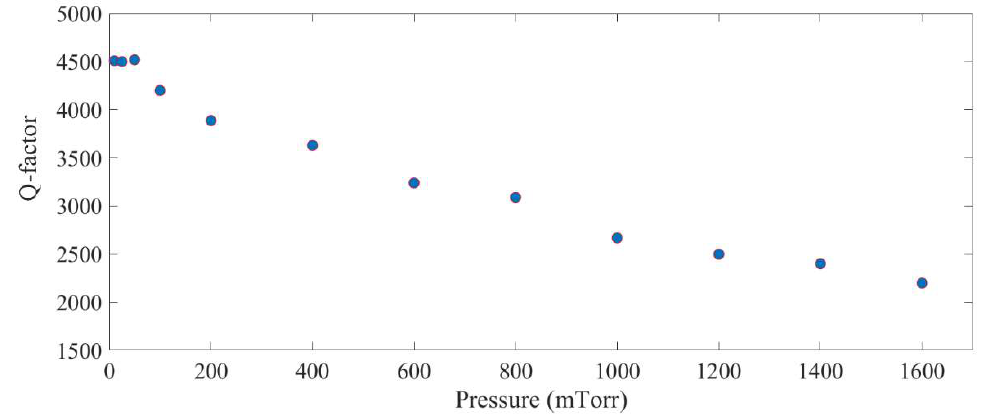
Figure 12. Quality factor of the sense mode of the structure while operating in its linear region.